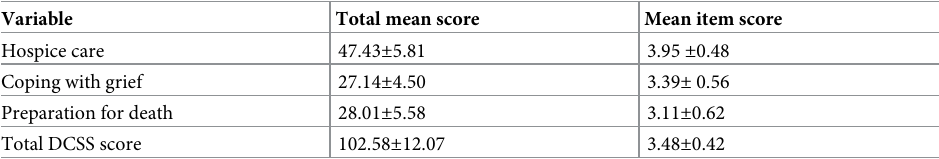
Table 4 shows correlations between the Big Five Personality Traits and different dimensions as well as with the total DCSS score. Extraversion, openness, agreeableness and conscientiousness were all positively associated with hospice care, coping with grief, preparation for death and with the total DCSS score. On the other hand, neuroticism was negatively associated with hos- pice care, coping with grief and the DCSS total score. Table 2. Death coping self-efficacy mean scores of nurses (n =